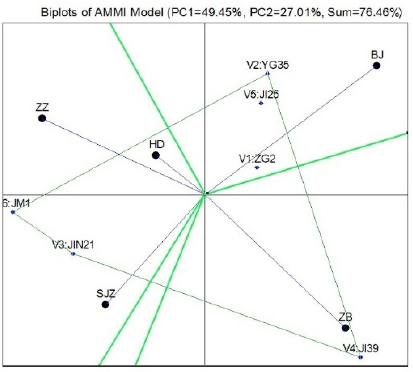
Figure 4. Polygon view of the AMMI biplot for 6 varieties evaluated across 5 study sites in 2020–2021. ZZ, SJZ, BJ, ZB, and HD represent 5 study sites. JIN21, JI25, JI39, YG35, JM1, and ZG2 represent 6 varieties.